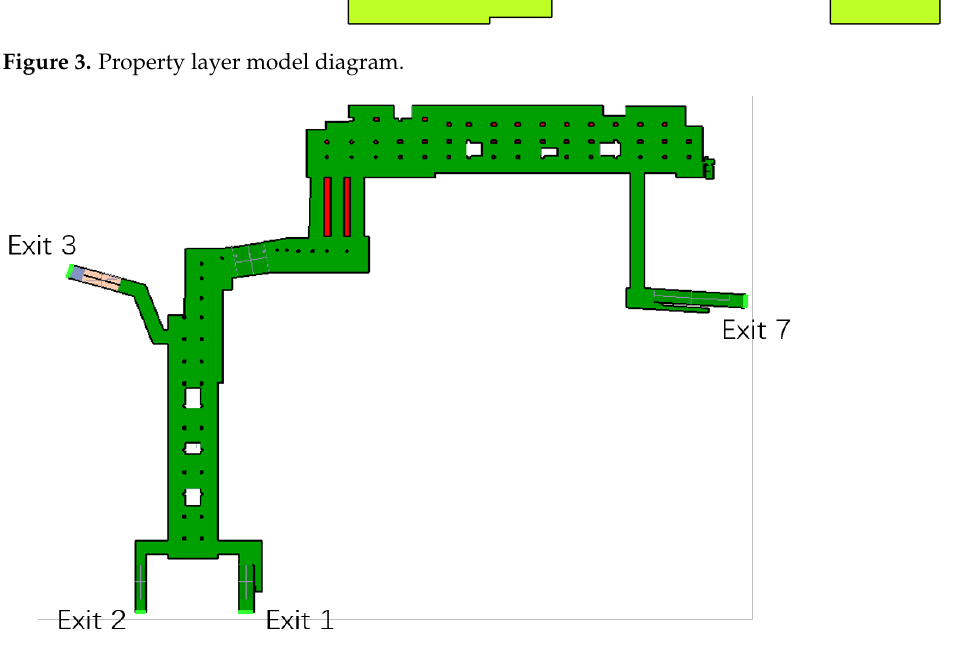
Figure 4. Station hall floor model plan.